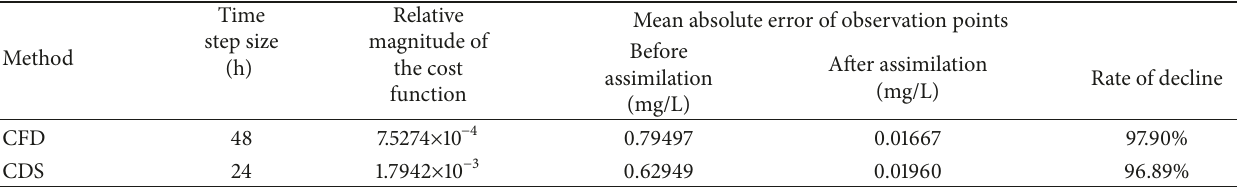
Figure 11: Figures of the source and sink terms inverted by the adjoint method of data assimilation with CFD and CDS. Table 7: The results of the adjoint model using CFD and